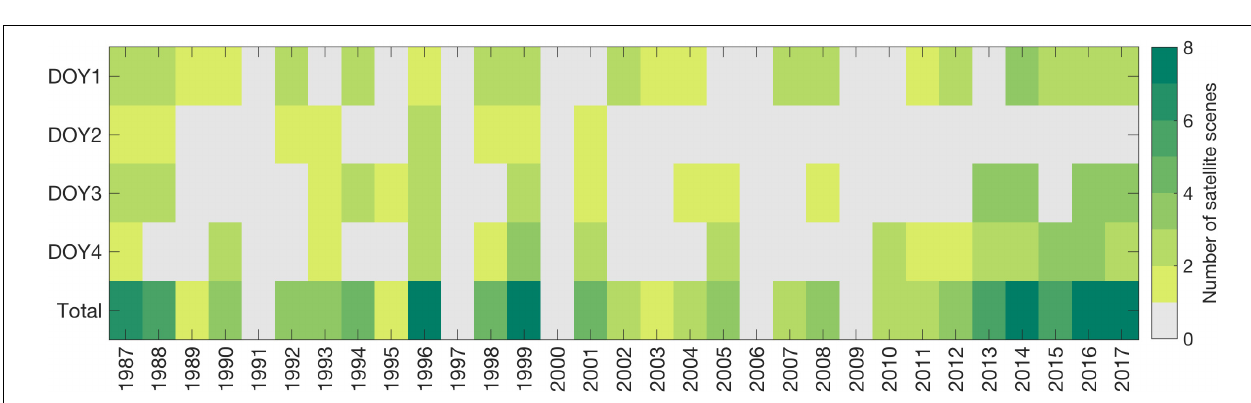
FIGURE 2 | Landsat 5, 7, and 8 data availability for the Dhofar mountain range from 1987 to 2017 for the selected NDVI threshold periods DOY1–DOY4 (cf “Forest